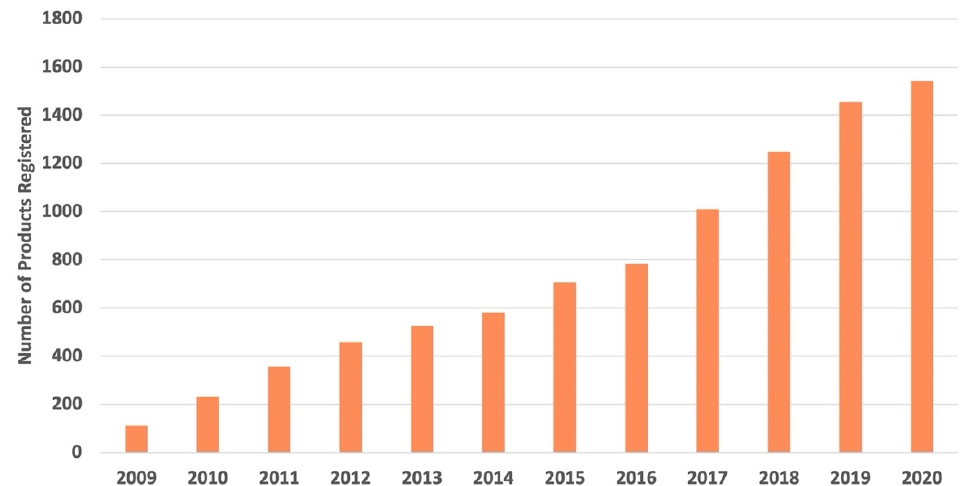
Figure 4. Whole Grain Stamp growth in Latin America.